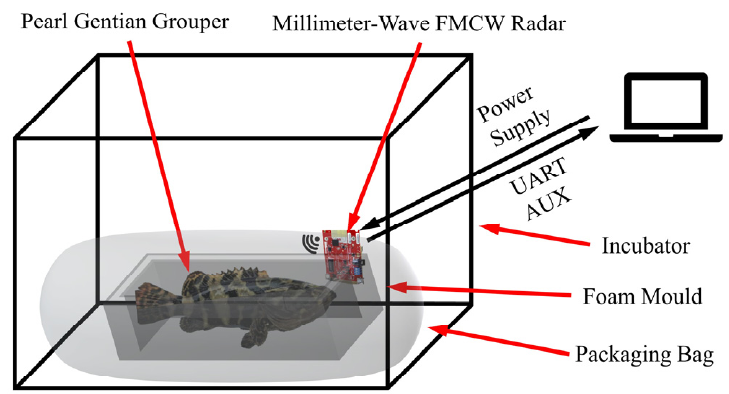
Figure 2. Schematic diagram of NDBRMS with the sensor fixed to the inner wall of the incubator and the radar antenna facing the gills.